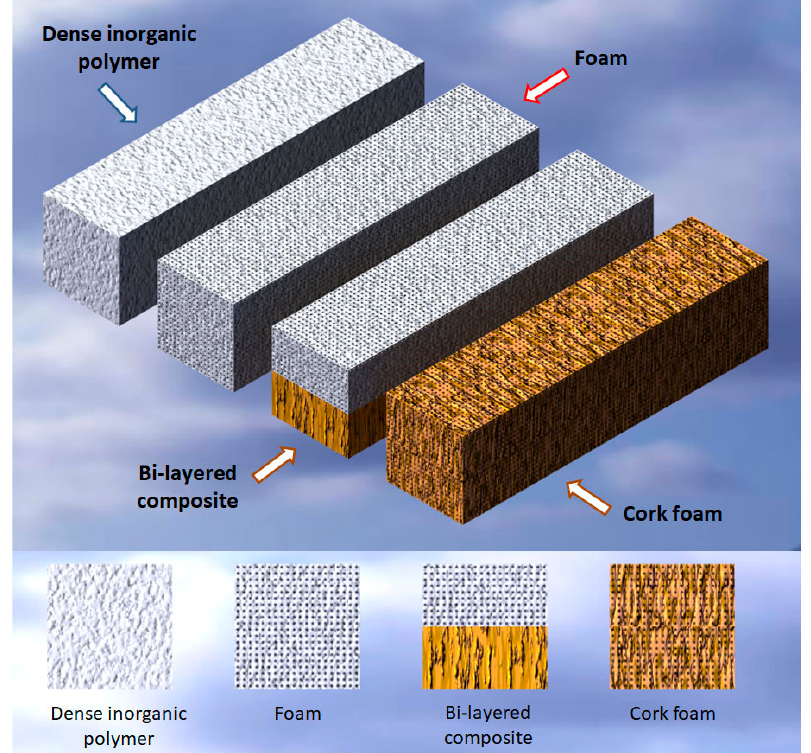
Figure 1. Schematic drawing of the distinct set of samples produced in this study: dense inorganic polymer, foams, bi-layered composites, and cork foams.